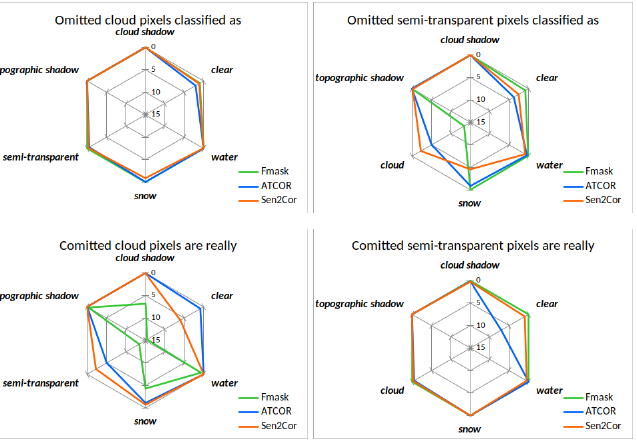
Figure 12. Omission and commission per Class for difference area for cloud classes cloud and semitransparent